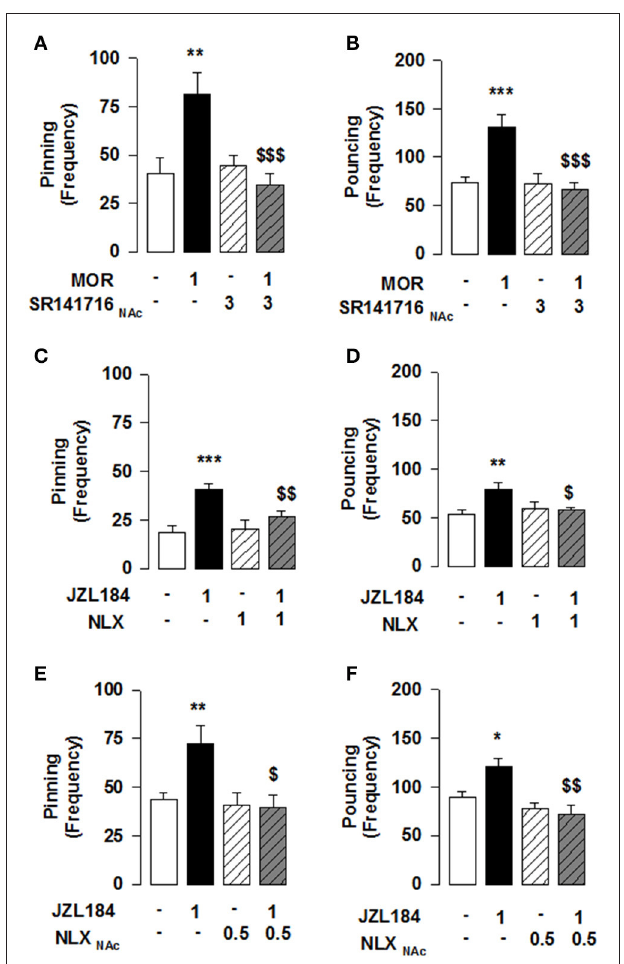
FIGURE 2 | MOR activation in the NAcC is necessary for the 2-AG induced stimulation of social play in adolescent rats. Play-enhancing effects of morphine (1mg/kg, s.c.) were prevented by intra-NAcC infusion of SR141716 (3 µ g/0.3 µ l) (A,B) . Systemic pretreatment with the OR antagonist naloxone (NLX: 1 mg/kg, s.c.) blocked the effects of JZL184 (1mg/kg, i.p.) on pinning (C) and pouncing (D) . Intra-NAcC infusion of NLX (0.5 µ g/0.3 µ l) antagonized the play-enhancing effects of JZL184 (1mg/kg, i.p.) (E,F) . Data represent mean ± S.E.M. frequency of pinning and pouncing. * p < 0.05; ** p < 0.01, *** p < 0.001 vs. vehicle; $ p < 0.05, $$ p < 0.01, $$$ p < 0.001 vs. vehicle/JZL184 and vehicle/morphine (Student-Newman-Keuls post-hoc test). N = 6–12 per treatment group.